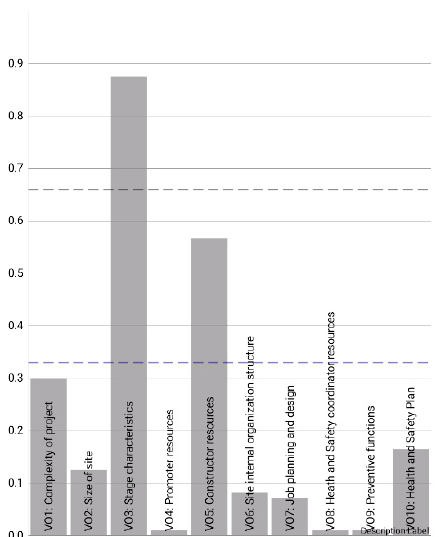
Figure A6. Criteria for reviewing the organizational and resources factors for the site. At the analyzed site, critical values for the risk variables have been detected: VR1, VR2, VR3, VR4, VR5, VR6, VR7, VR8, and VR9. Consequently, the following aspects must be revised regarding the available resources and means on-site: The complexity of the project, configuration, environment, and/or the size of the site. The constructor’s available resources according to his/her typology. The adequacy and sufficiency of the human resources available on-site (supervisors, site leaders, etc.). The type of contracting (one or more contractors), number of firms at the site, and their level of subcontracting.